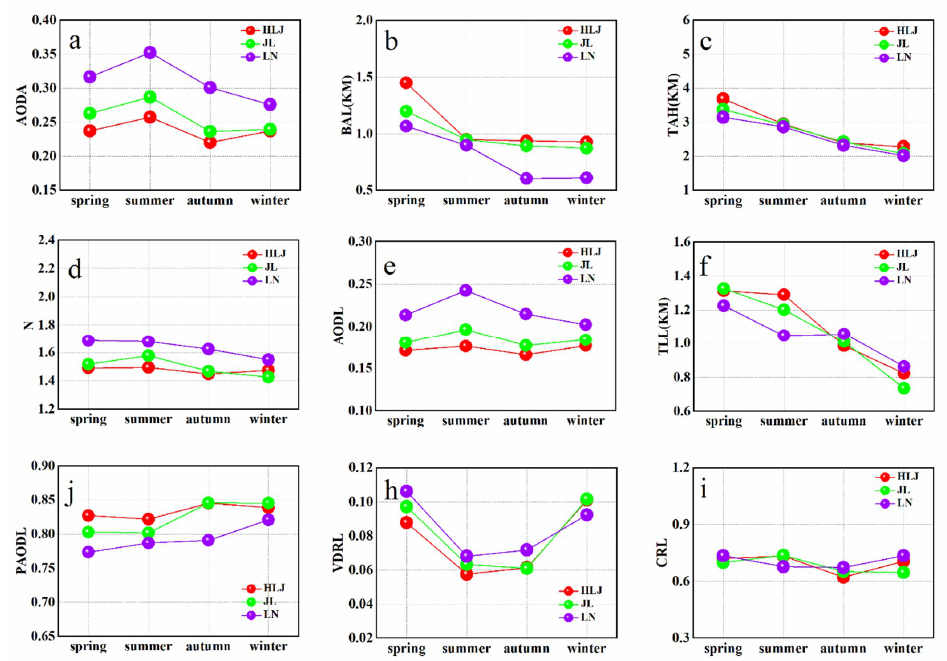
Figure 6. Seasonal variations in the optical and physical properties of aerosol layers over NEC (HLJ, JL, and LN) in the daytime, from 2007 to 2014. ( a ) AODA, ( b ) BAL, ( c ) TAH, ( d ) N, ( e ) AODL, ( f ) TLL, ( g ) PAODL, ( h ) VDRL, and ( i ) CRL.